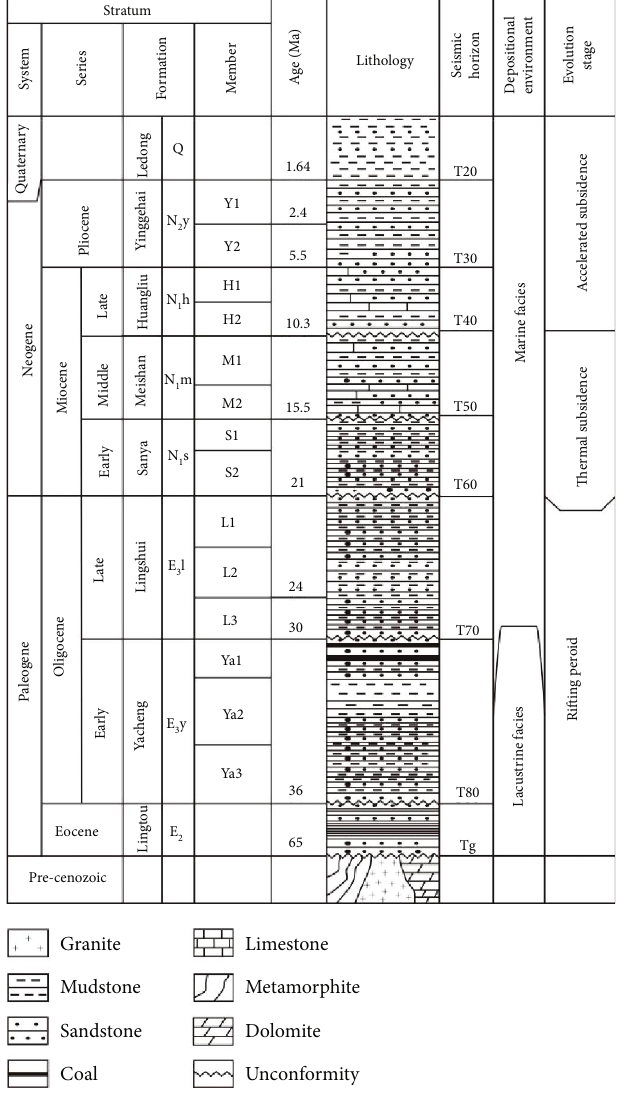
Figure 2: Generalized stratigraphic column of the QDNB (modi fi ed from [30,